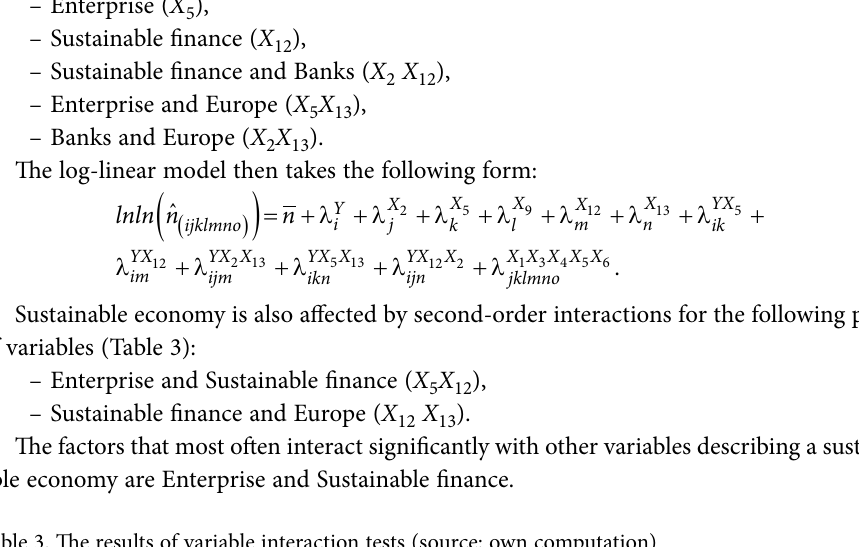
Table 3. The results of variable interaction tests (source: own computation) Degree of